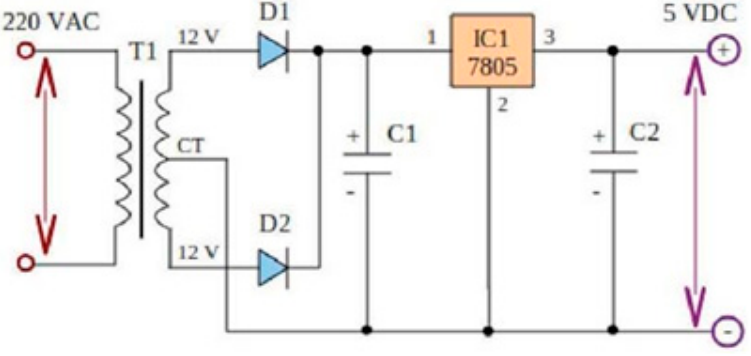
Figure 9. Electrical circuit.